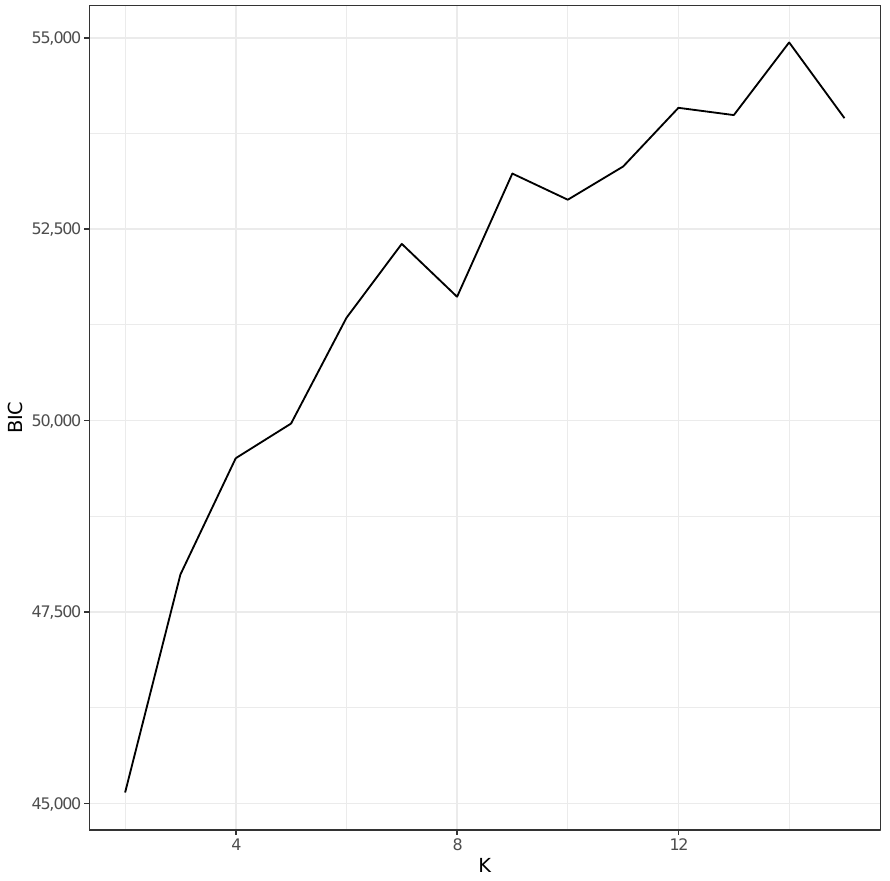
Figure 4. Bayesian Information Criterion (BIC) calculated for the functional mixture model over K = 2, 3, ···, 15. The BIC is maximized at K = 14.